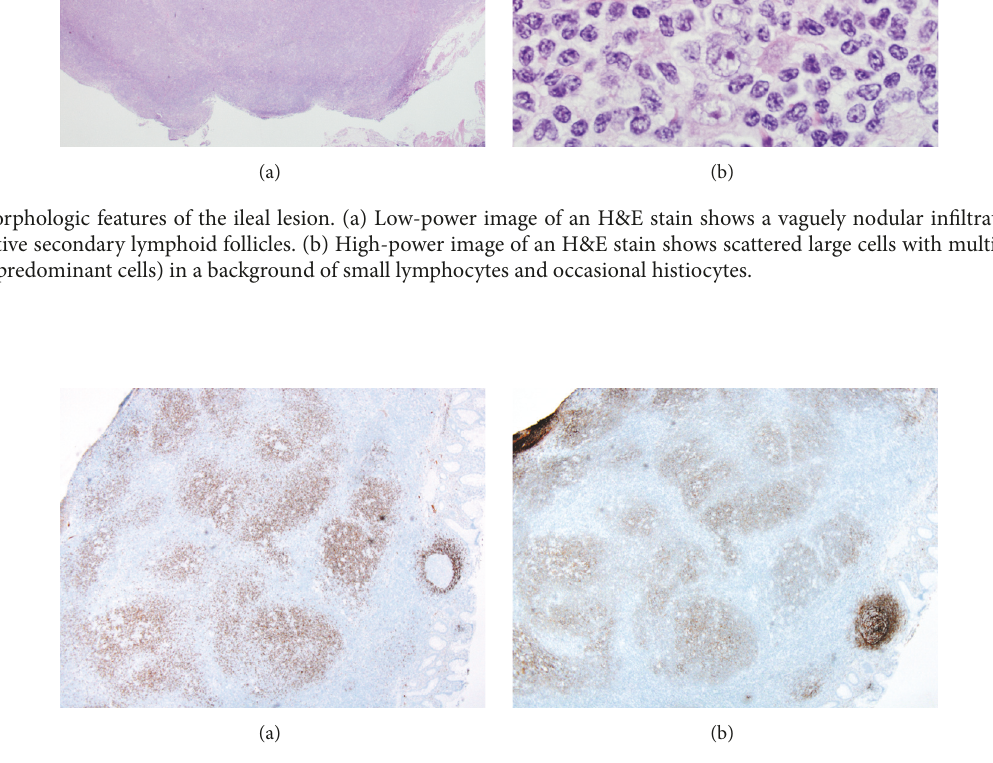
Figure 3: Immunoarchitecture of the ileal lesion. (a) Low-power image of an IgD immunohistochemical stain shows numerous positive cells within the nodules. The mantle zone of an adjacent reactive follicle is also seen (right). (b) Low-power image of a CD21 stain shows expanded follicular dendritic cell meshworks associated with the